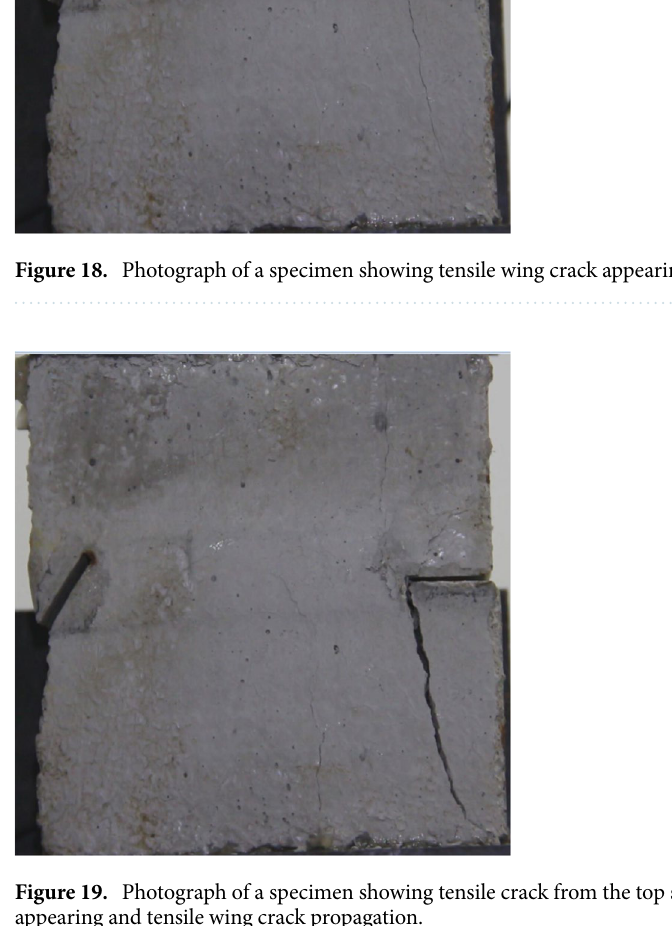
size range had the largest average grain size.